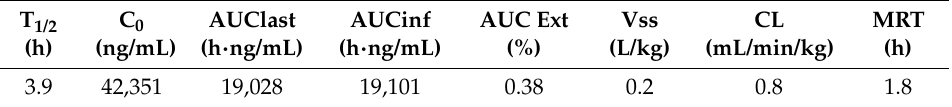
Figure 2. Mean concentration-time profile (± SD) after IV administration of 2 mg/kg NUC050 in mice. Table 4. Pharmacokinetic parameters after 2 mg/kg IV NUC050 administration in mice. Where, T 1/2 : half-life, C 0 : concentration at time 0, AUClast: area under the curve to the last time point, AUCinf: area under the curve extrapolated to infinity, AUC Ext: Proportion of AUC extrapolated, Vss: volume of distribution at a steady state, CL: clearance, MRT: mean residence